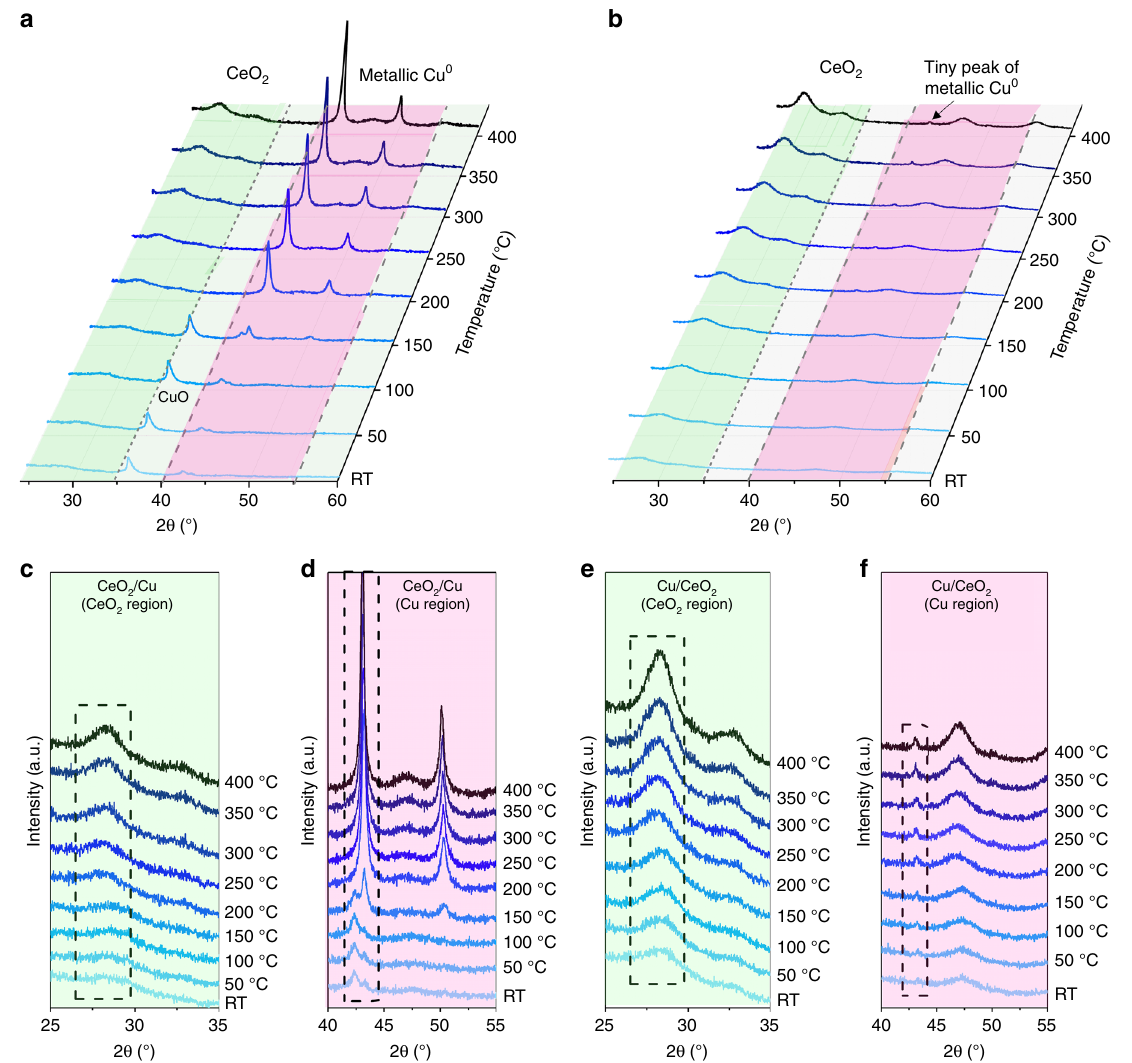
Fig. 3 Simulation of sintering via in situ XRD. a In situ XRD patterns under 5% H 2 – Ar for inverse CeO 2 /Cu catalyst. b In situ XRD patterns under 5% H 2 – Ar for normal Cu/CeO 2 catalyst. c Ampli fi ed CeO 2 region of in situ XRD patterns for inverse CeO 2 /Cu catalyst. d Ampli fi ed Cu region of in situ XRD patterns for inverse CeO 2 /Cu catalyst. e Ampli fi ed CeO 2 region of in situ XRD patterns for normal Cu/CeO 2 catalyst. f Ampli fi ed Cu region of in situ XRD patterns for normal Cu/CeO 2